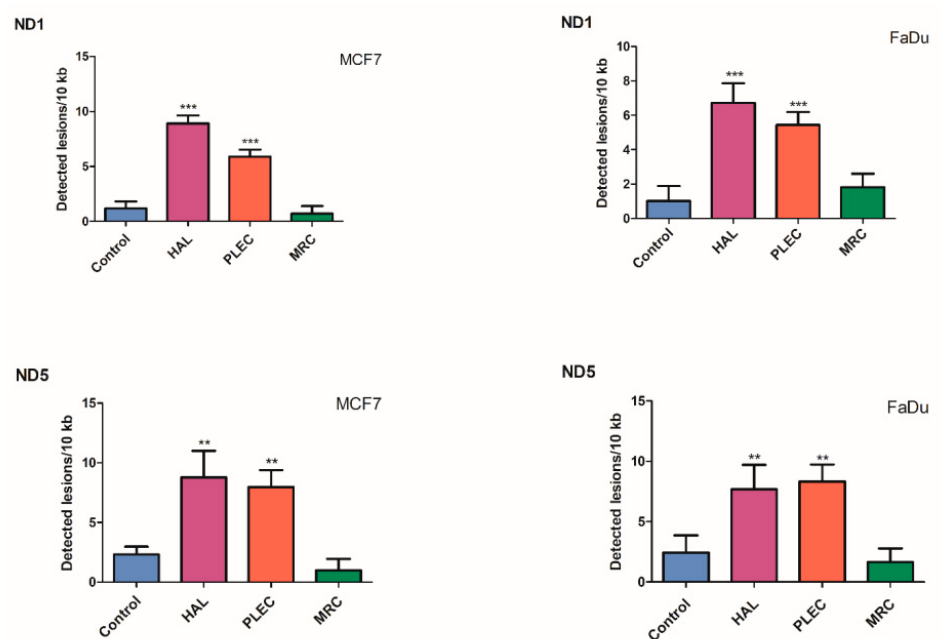
Figure 6. Quantification of mitochondrial DNA (mtDNA) lesion frequency per 10 kb DNA by SLR- qRT-PCR amplification of total DNA from MCF7 and FaDu cells exposed to HAL, PLEC and MRC for 24 h. Data represents the mean ± SD of three replicates. ** p < 0.01; *** p < 0.001 vs. control group.